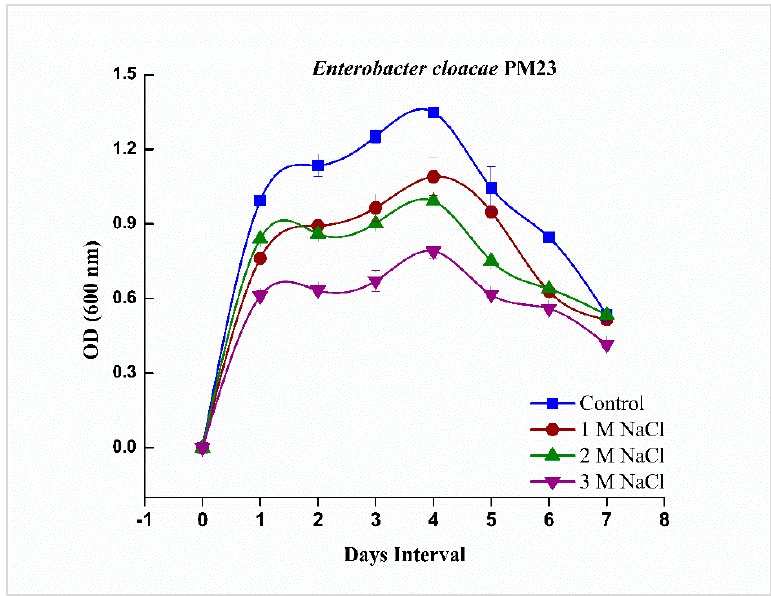
Figure 1. Growth curve analysis of E. cloacae PM23 under salinity stress (0, 1, 2 and 3 M NaCl).